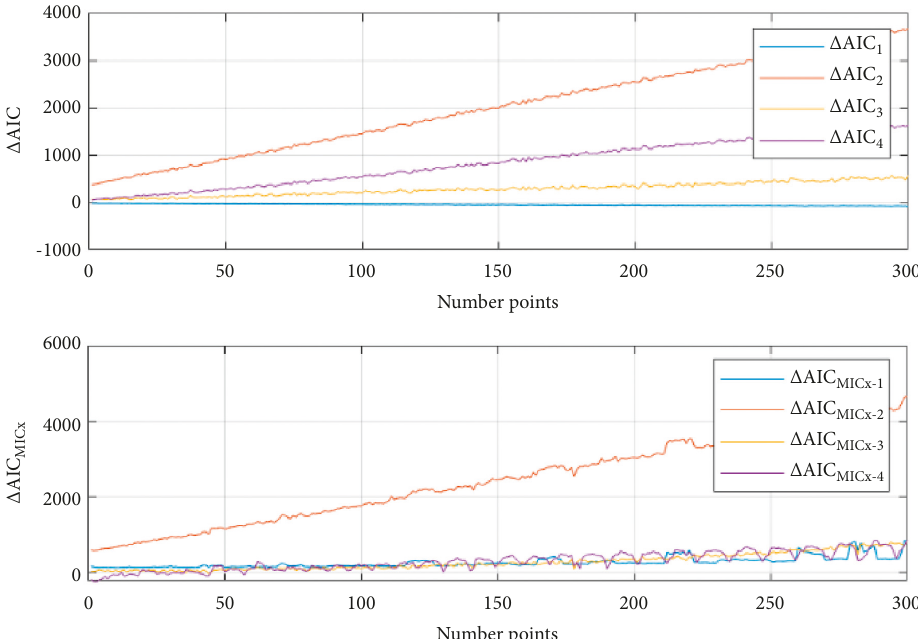
Figure 2: Comparison of the discriminating power of the traditional AIC and the proposed AIC the indicators for the various models and the reference one used to generate the data, is reported. On the ( x ) axis a scan in the number of